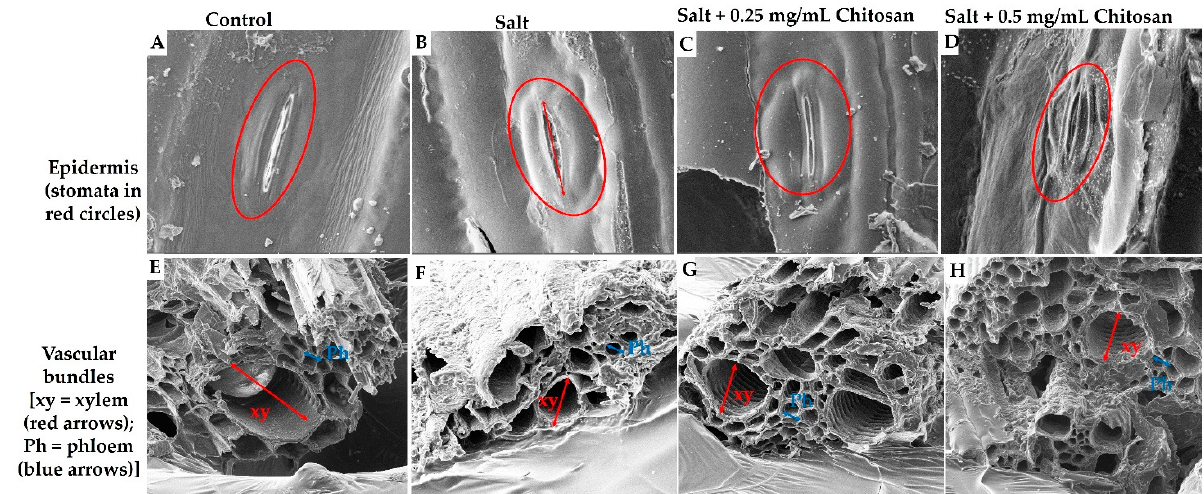
Figure 2. The positive effects of chitosan on the stomata (red circles, ( A – D )) and vascular bundle layers (xylem = red arrows and phloem = blue arrows; ( E – H )) of sorghum under salt stress. ( A , E ) (0 mM NaCl); ( B , F ) (300 mM NaCl); ( C , G ) (salt + 0.25 mg/mL chitosan); ( D , H ) (salt + 0.5 mg/mL chitosan).